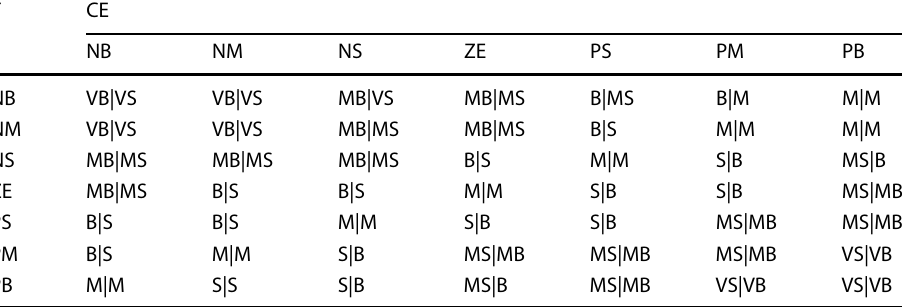
Table 2 Rule base of u 1 ∕ u 2 for fuzzy logic controller